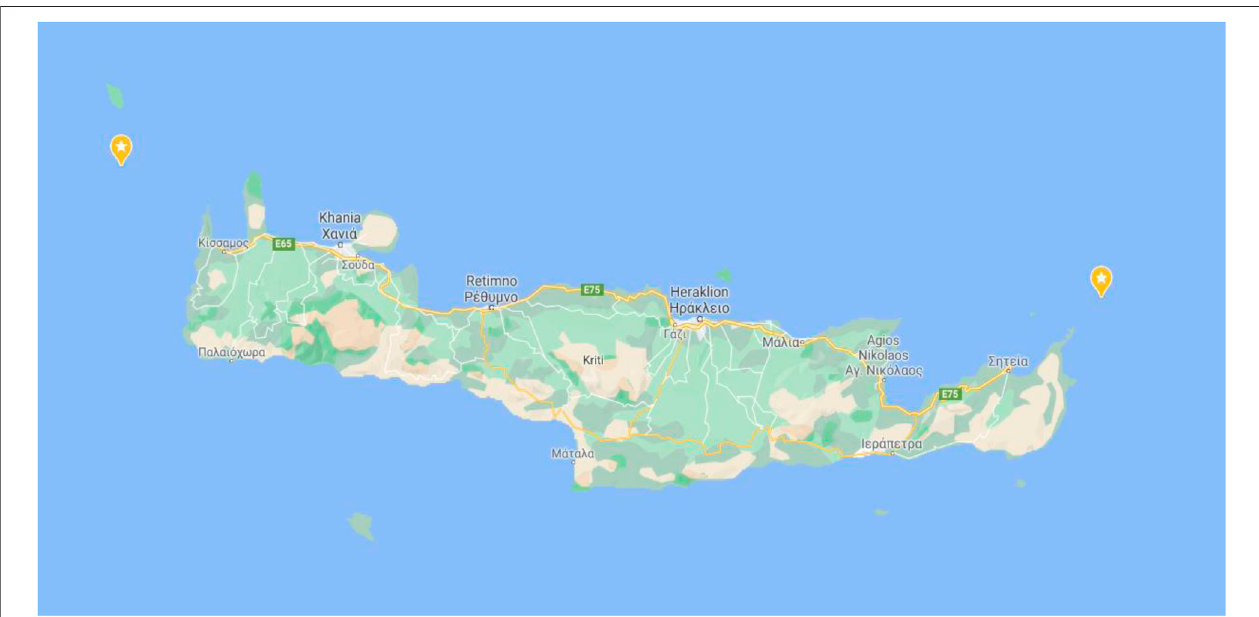
FIGURE 2 | Potential locations for offshore wind